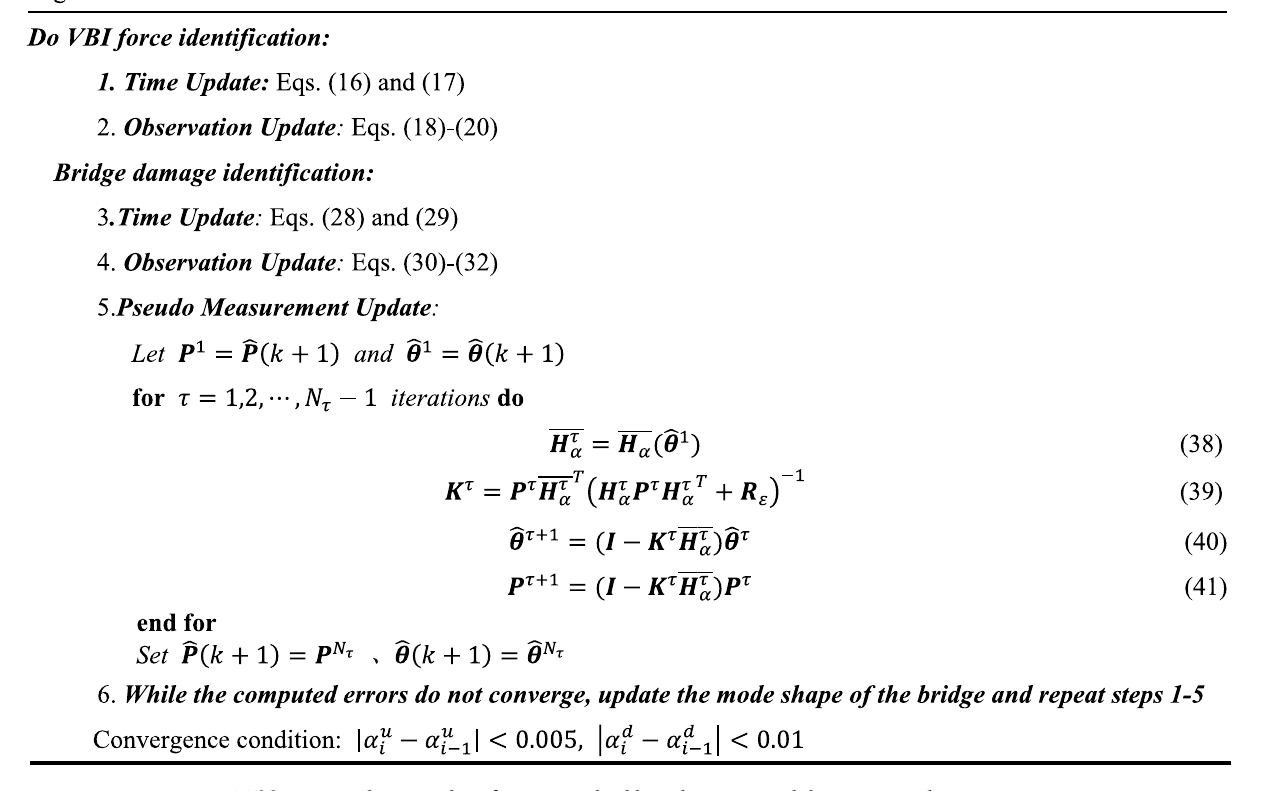
Table 1. Step-by-step identification method based on EKF with l1-norm